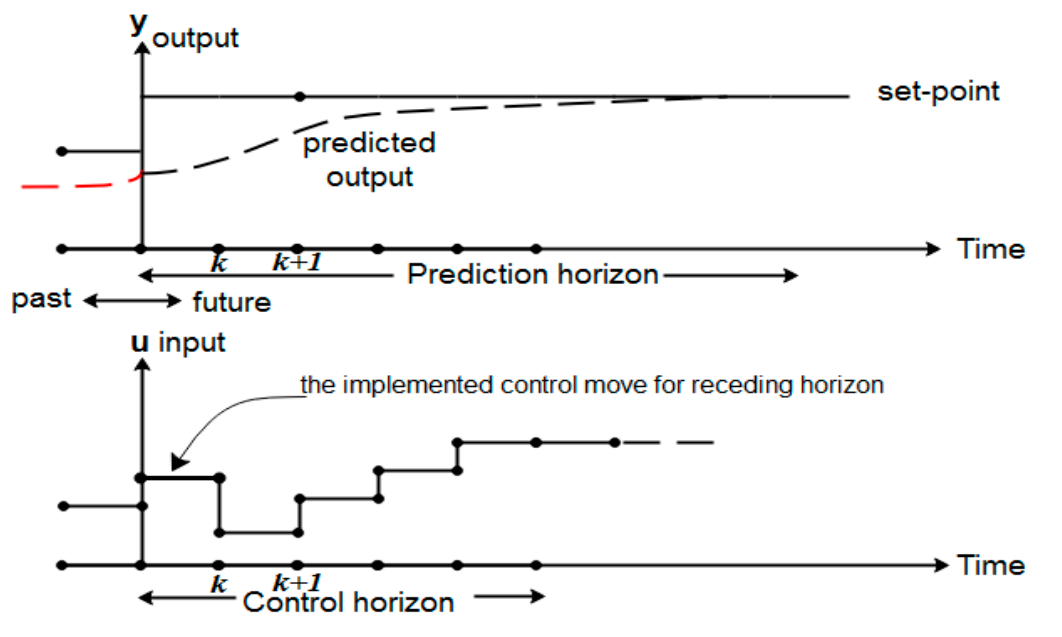
Figure 8. The basic idea of receding horizon control.